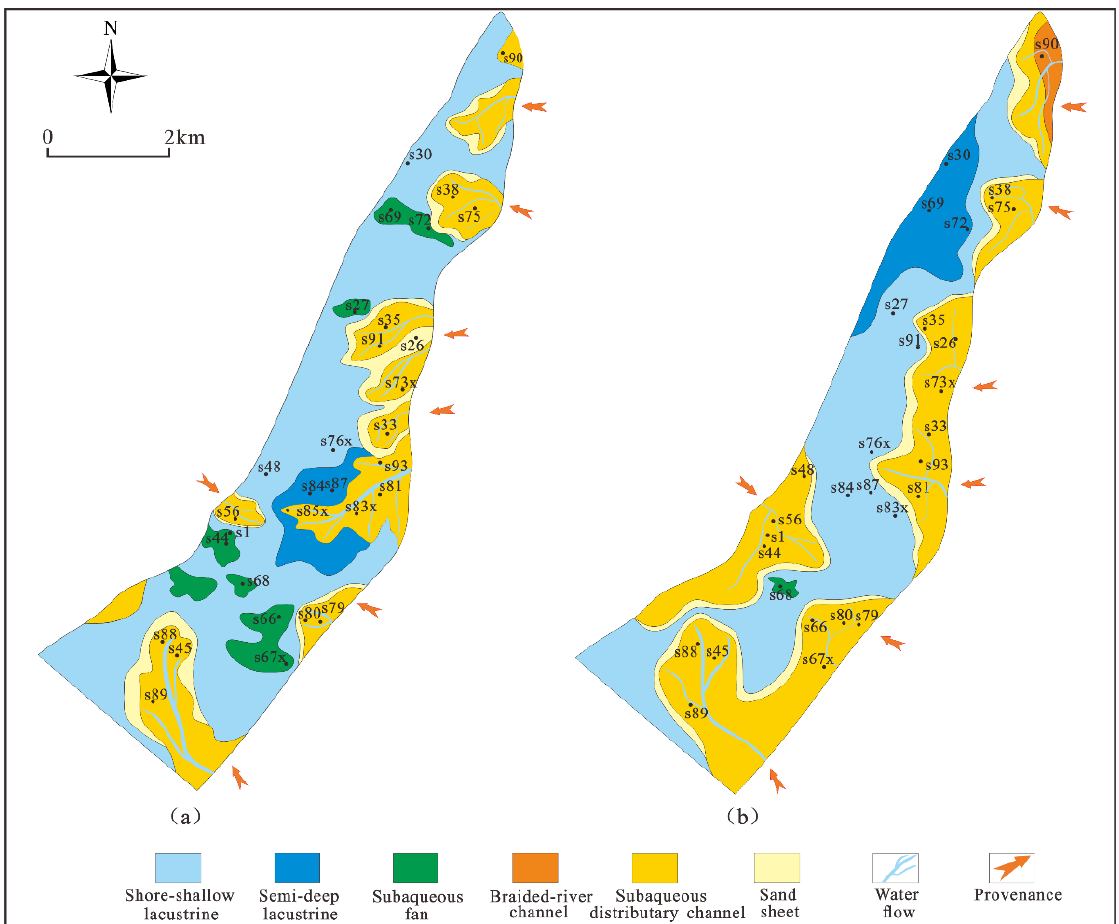
Figure 9. Planar distribution of sedimentary facies in Saidong sub-sag. ( a ) The V sand formation period of K 1 bt 2 and ( b ) the IV sand formation period of K 1 bt 2.